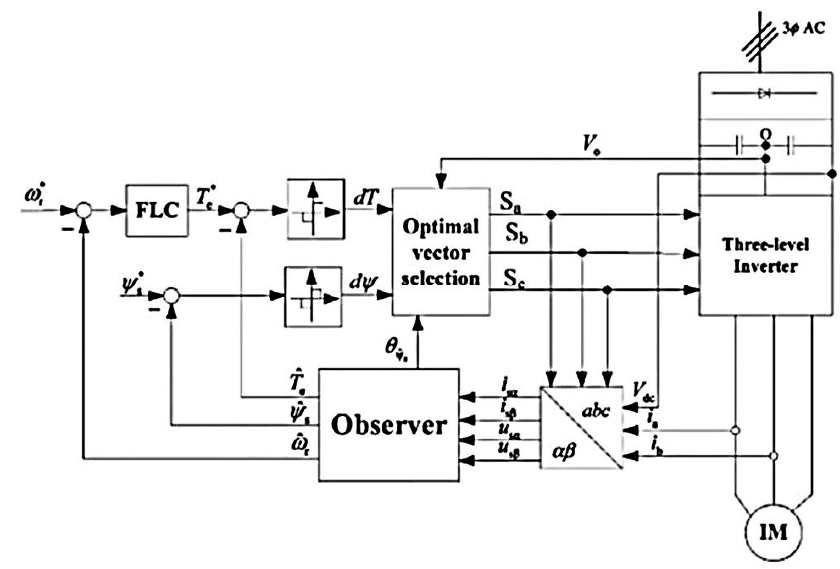
Figure 30. Sensorless three-level DTC actuator.